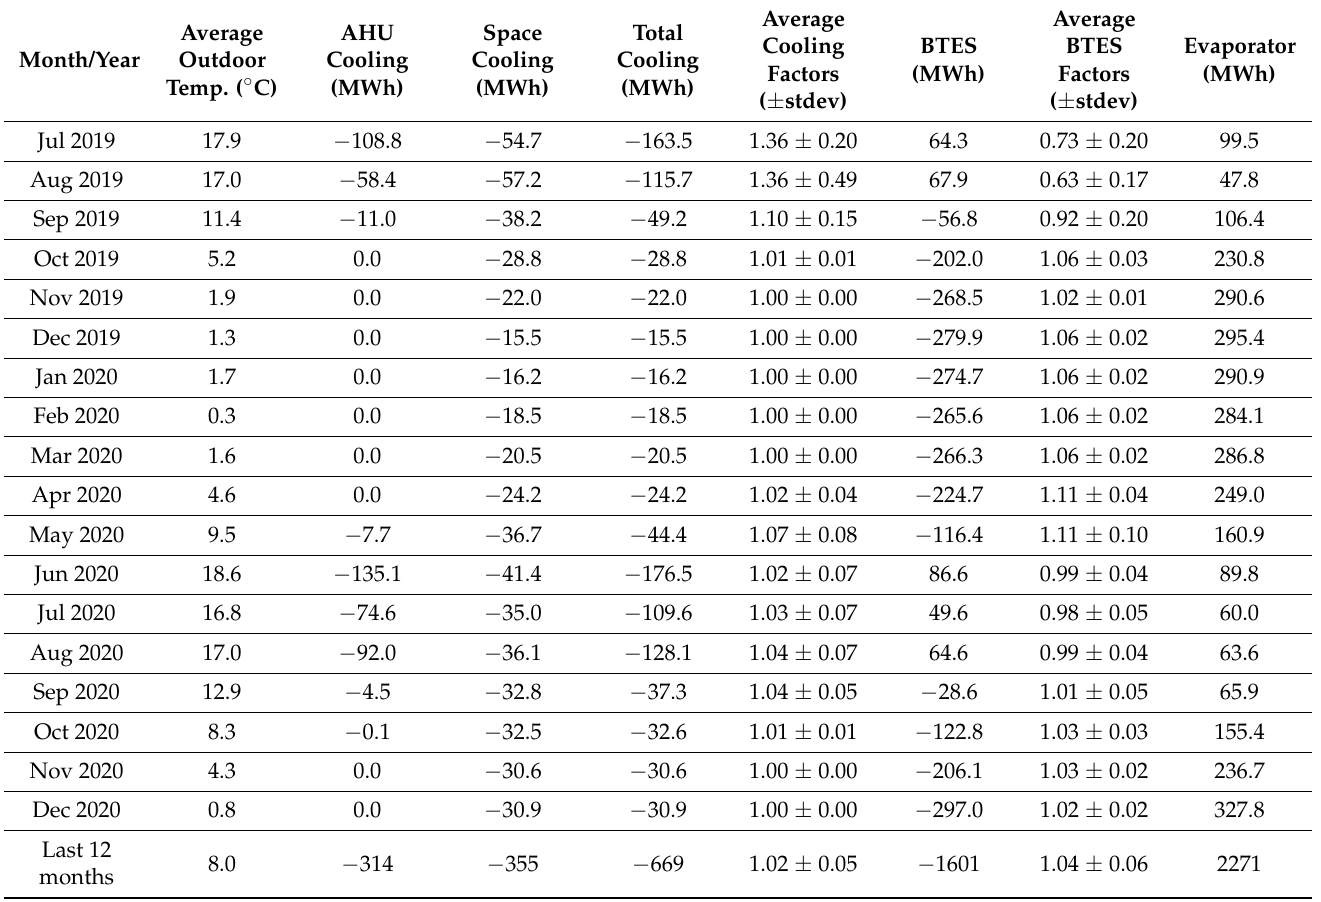
Table 6. Data management: results of the evaporator